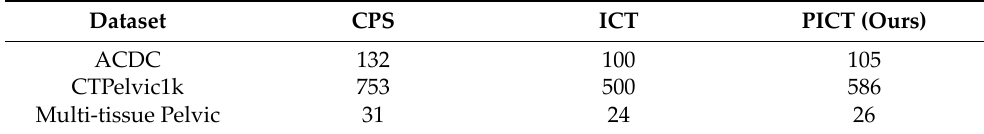
Table 8. The time cost of ACDC. CTPelvic1k, Multi‑tissue dataset; the unit is